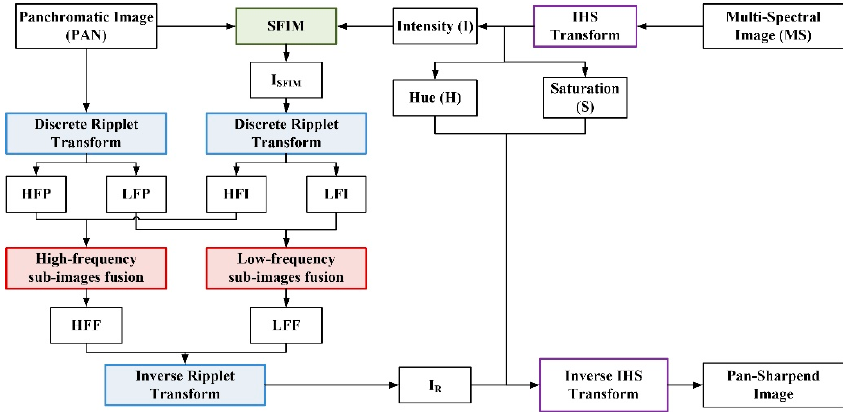
Figure 2. The technical flow of the proposed pan-sharpening method.